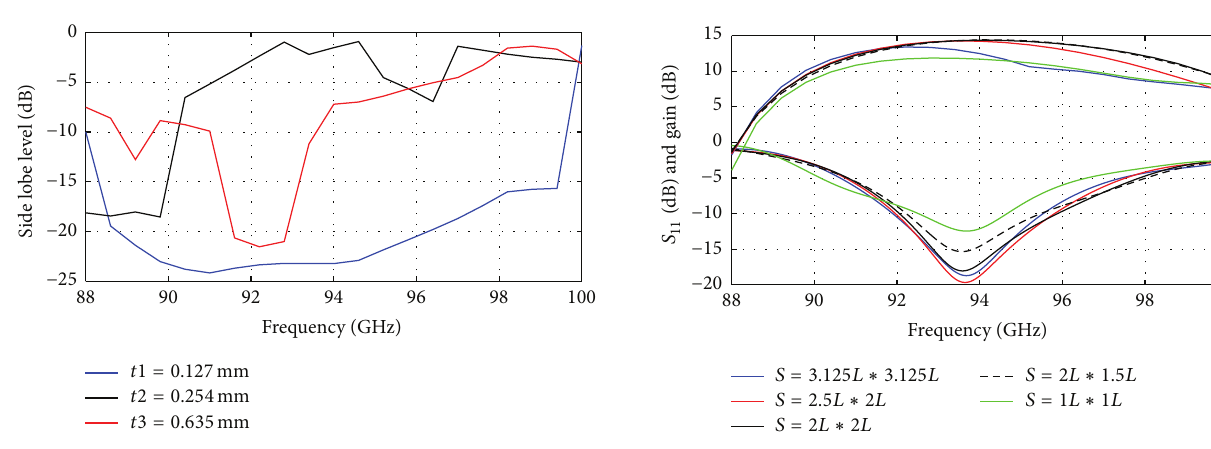
Figure 11: Variation of 𝑆 11 and gain for different dimensions size 𝑆 with a fixed superstrate height of ℎ = 0.6𝜆 0 .